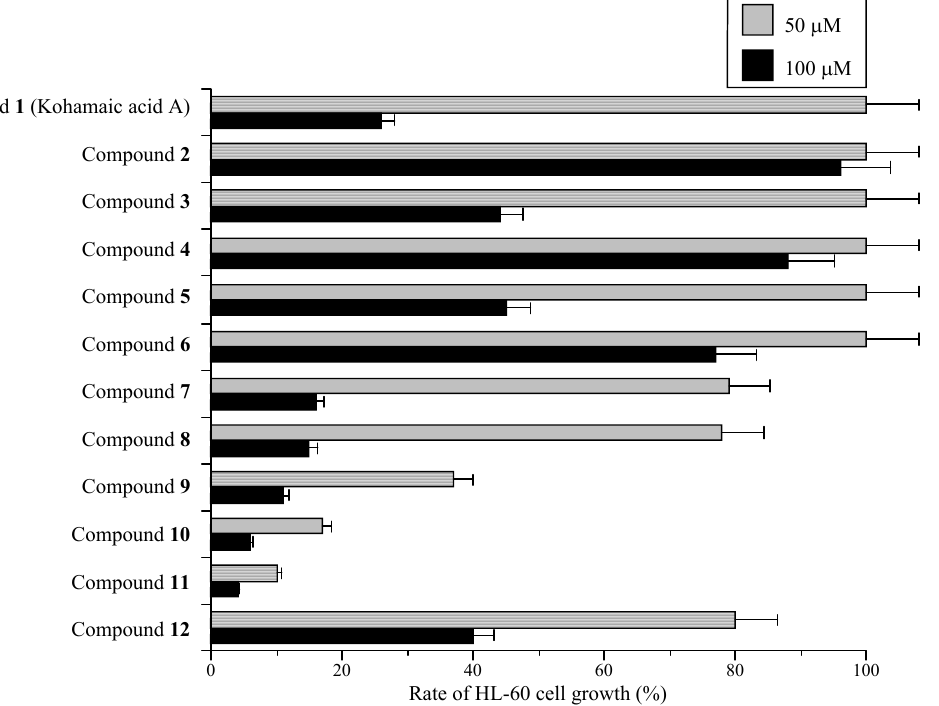
Figure 3. Effects of kohamaic acid A derivatives (compounds 1 – 12 ) on proliferation of HL-60 cancer